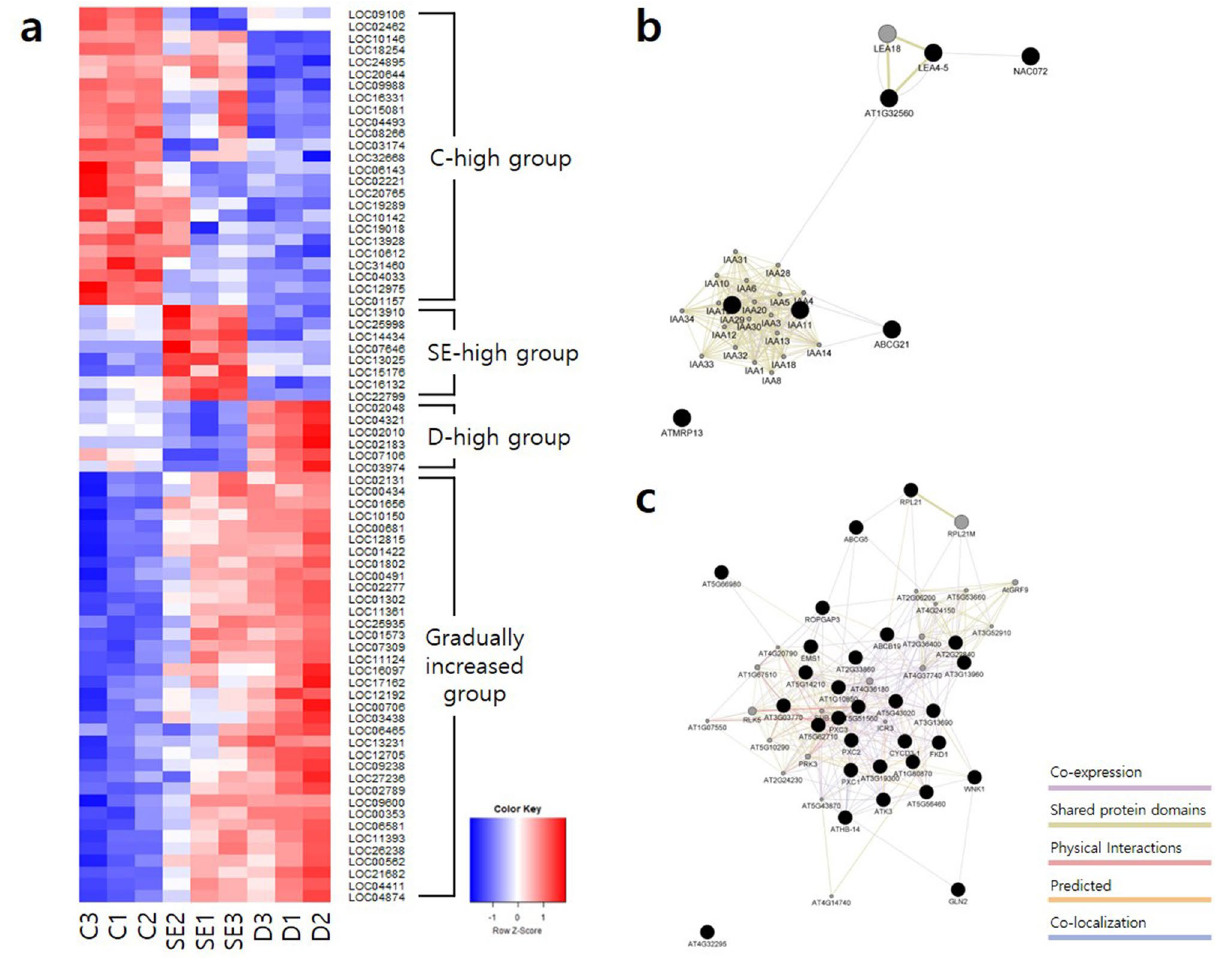
group. Black circle, input genes. Gray circle, neighborhood